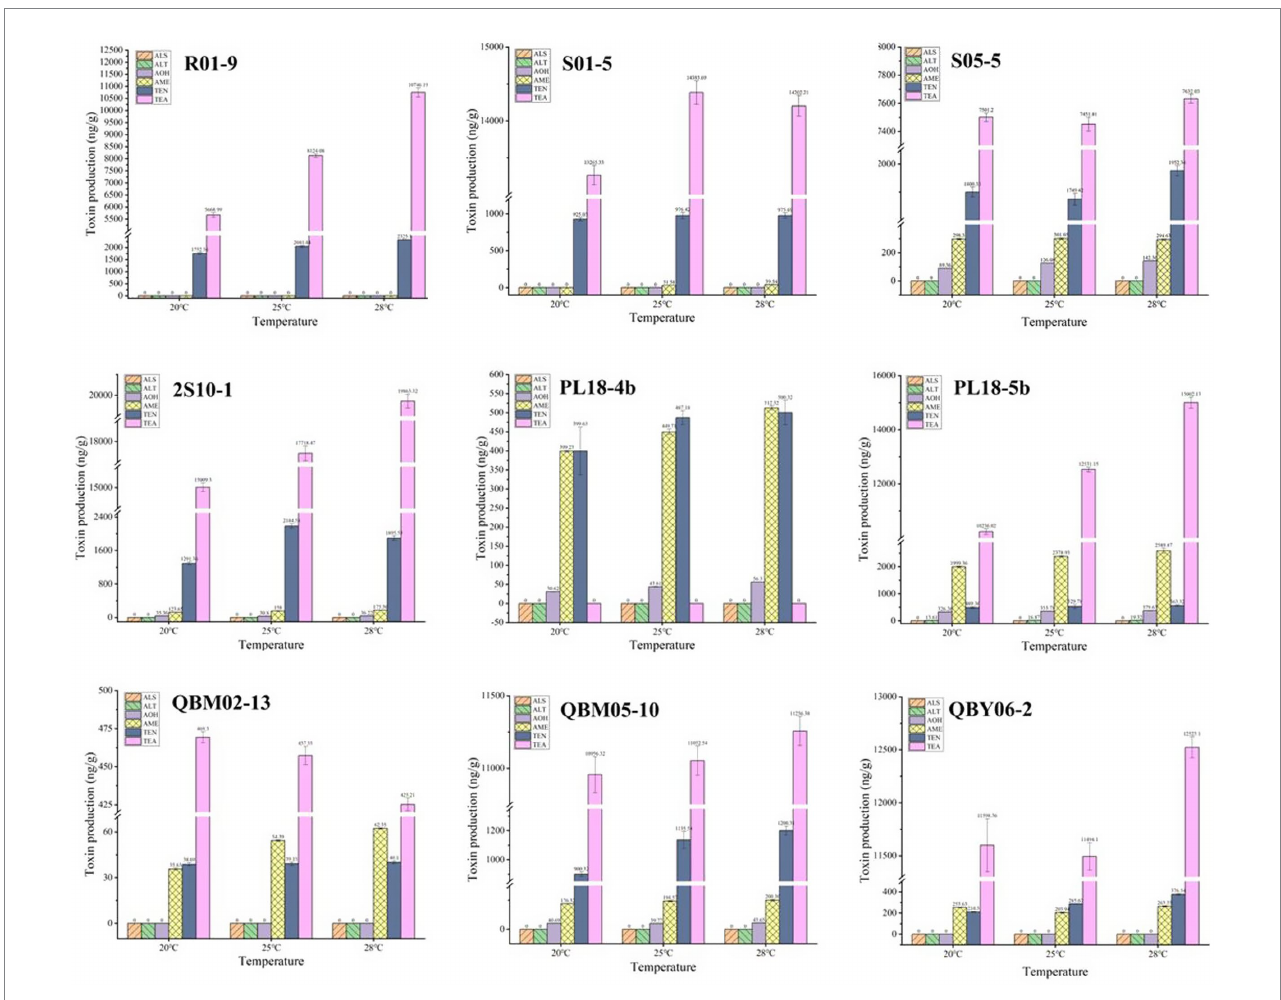
FIGURE 4 The toxin-production ability of nine Alternaria alternate at different